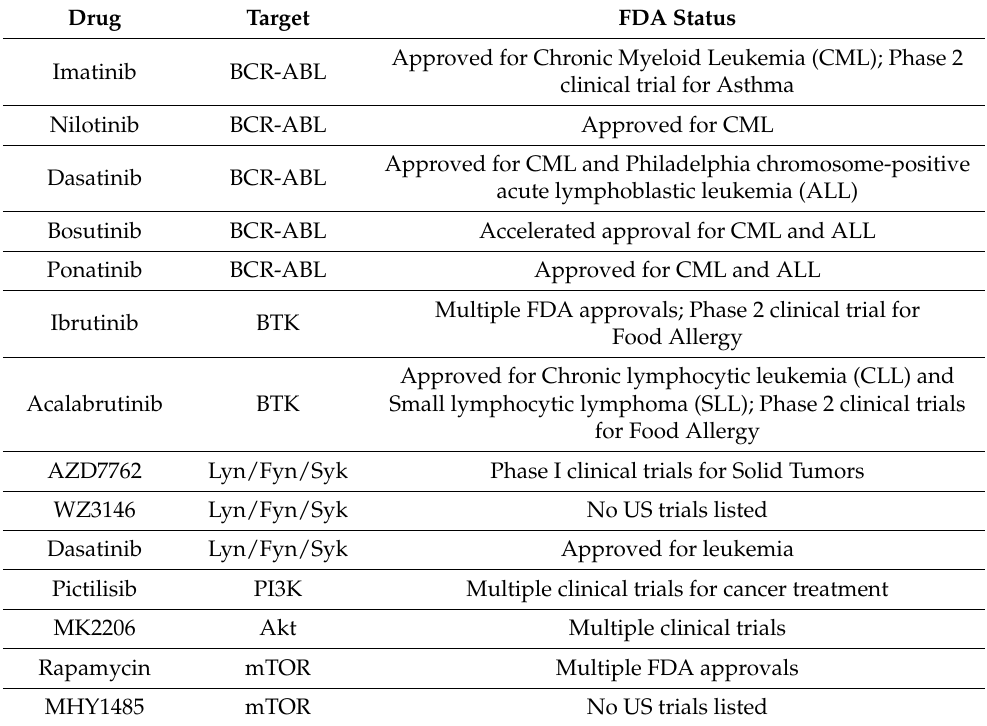
Table 2. Kinase inhibitors with known or likely uses in allergic